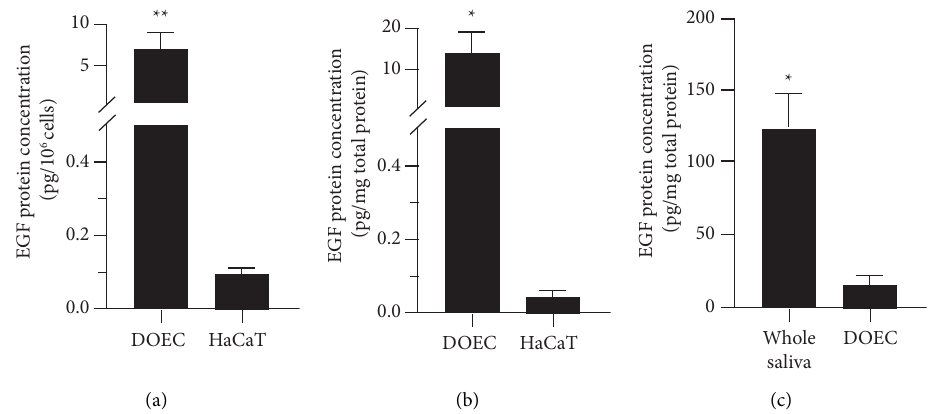
Figure 4: DOECs contain EGF protein as shown by ELISA analysis. (a, b) EGF protein concentration was investigated in DOECs and human keratinocyte HaCaT cell lysates with ELISA and expressed as pg/10 6 cells (a) or pg/mg total protein (b). (c) EGF concentration (pg/mg total protein) determined in unstimulated whole saliva and DOECs using ELISA. Each sample was analyzed in duplicate. Values are presented as means ± SEM for 4 (number of individuals) or 6 (number of wells with HaCaT cells) observations in each group. Statistical signifcance was calculated by Student’s two-tailed t test for single comparisons between the two groups (DOECs vs . HaCaTcells and whole saliva vs . DOECs) as appropriate. ∗ represents P < 0 . 05, and ∗∗ represents P < 0 . 01.